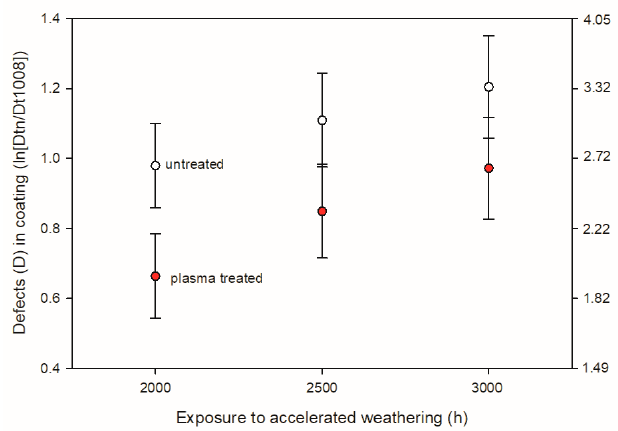
Figure 4. Effects of plasma treatments on defects present in solvent-borne coating on samples exposed to artificial accelerated weathering for 2016, 2520, and 3024 h. Results are averaged across radial and tangential samples pre-treated with plasma for different periods of time because there was no significant ( p > 0.05) effect of sample orientation on coating failure. Ratios are expressed on logarithmic scale on the y -axis, but they are expressed on a natural scale (e x ) on the y -2 axis. Error bars represent ± standard error of difference derived from ANOVA ( p < 0.05).